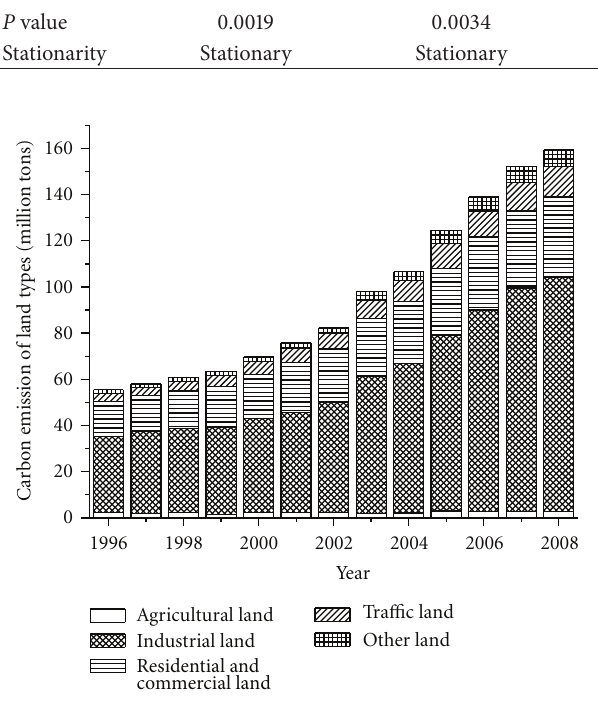
Figure 6: Energy-related carbon emissions in different land use types.